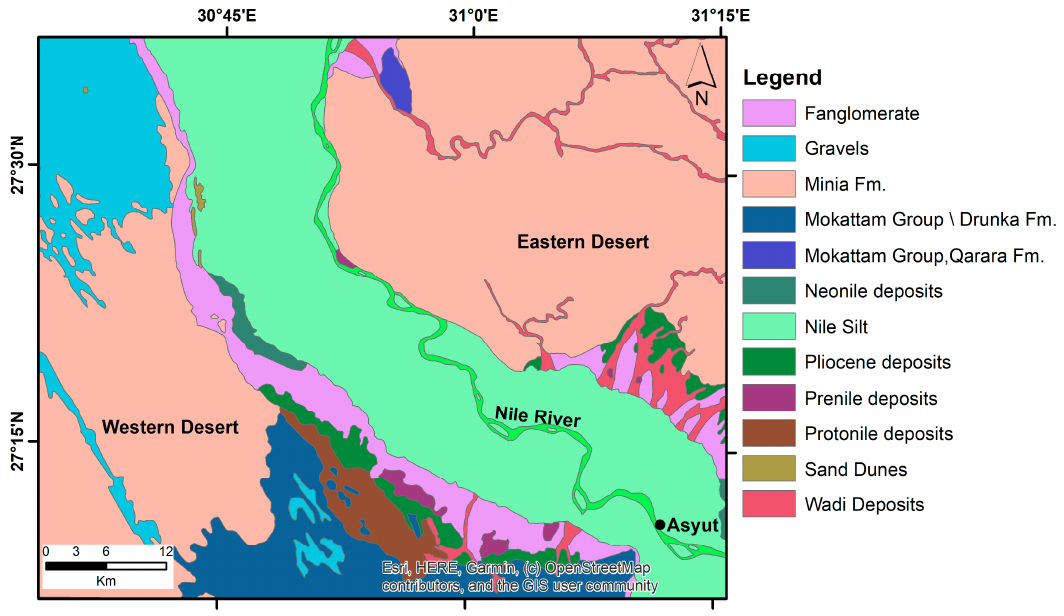
Figure 1. Location map showing the study area.